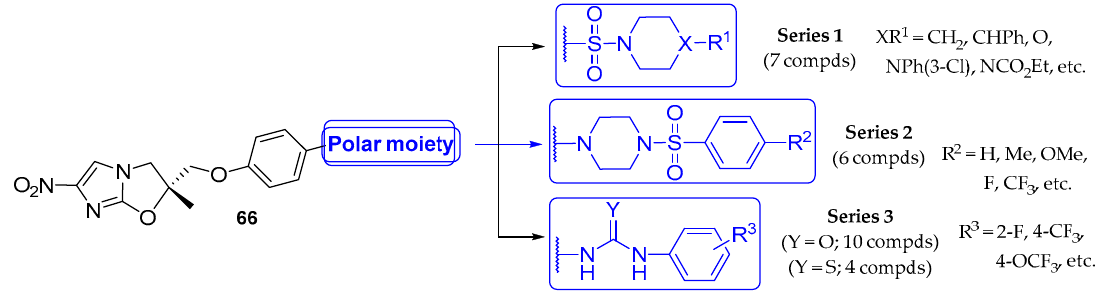
Figure 16. 6-Nitroimidazooxazoles ( 66 ) with solubilizing polar moieties.